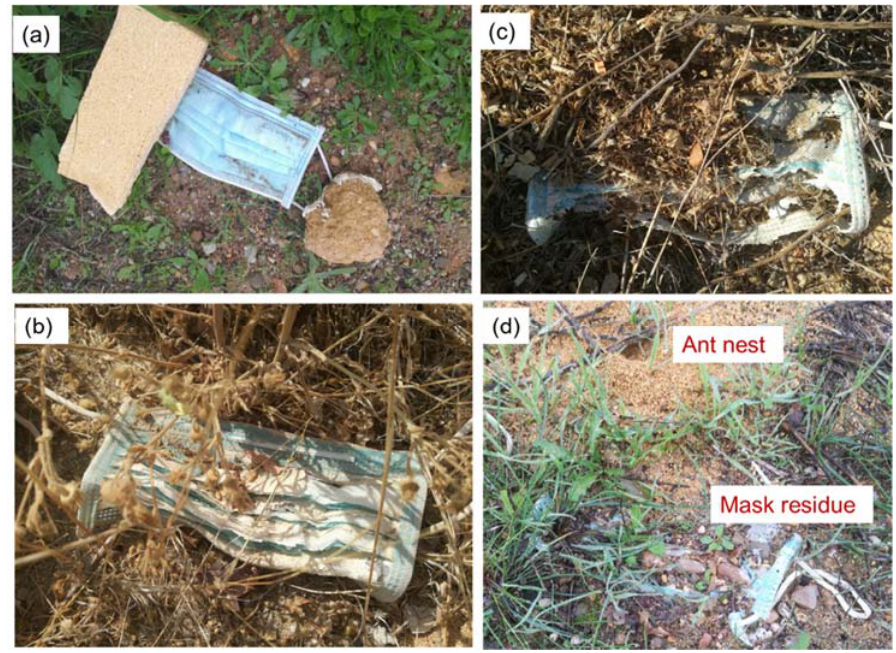
Figure 1. Surgical face mask, unintentionally deposited on a fallow close to Seville in Southern Spain during its natural degradation. The photos were taken on ( a ) 16 December 2020; ( b ) 11 August 2021; ( c ) 22 October 2021 and ( d ) 4 January 2022. In order to avoid dislocation of the mask, i.e., by wind, the strings were fixed with stones at the start of the monitoring ( a ). However, the stones were removed by unknowns between August and October 2021.